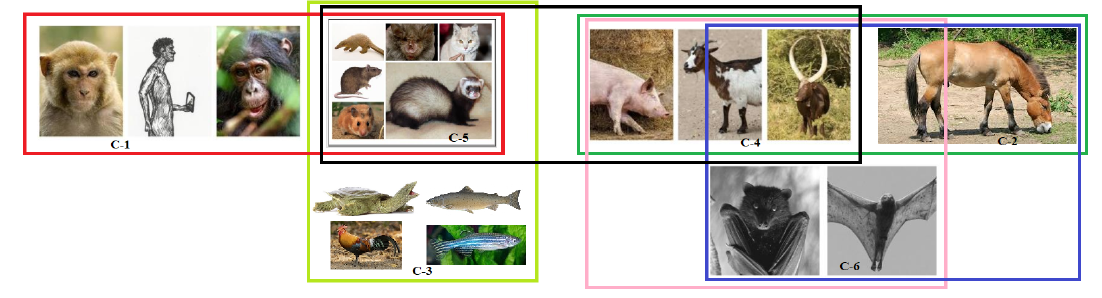
Figure 13. Schematic representation of a possible set of clusters of transmission of